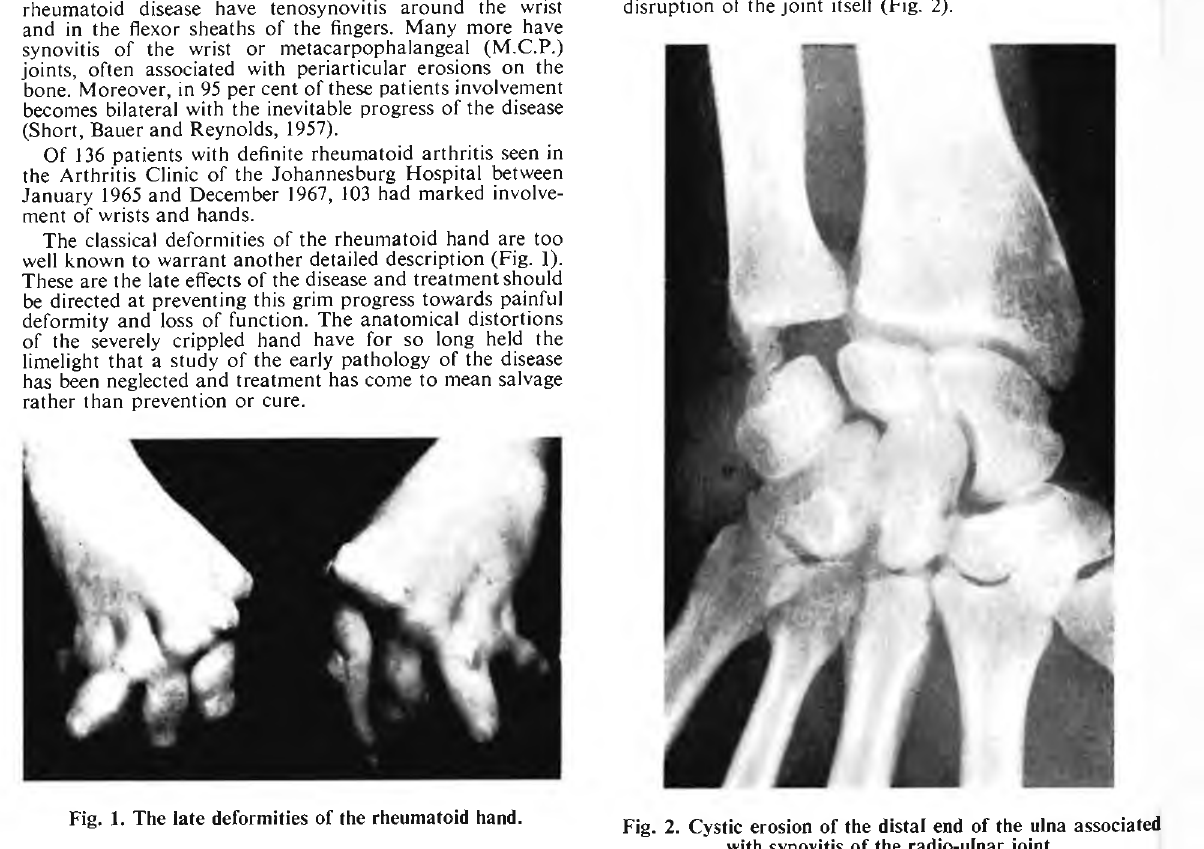
with synovitis of the radio-ulnar joint. The diagnosis is important for this may be the first stage in a recognizable march of events: painful radio-ulnar joint— radial deviation of the carpus (Fig. 3)— ulnar devia­ tion of the fingers to restore the alignment of the hand. It is significant that the vast majority of patients with established deformities of the fingers also have disease of the wrist with radial deviation of the carpus. Contrariwise, in Still’s disease which is frequently associated with dysplasia of the distal end of the ulna and ulnar deviation of the carpus, there is usually no ulnar deviation of the fingers. Treatment: Splinting of the wrist in the neutral position affords both rest for the inflamed joint and a gentle correc­ tion of the deformity. The resting splints, which are moulded out of plaster of Paris, duralumin or polyvinyl sheets,